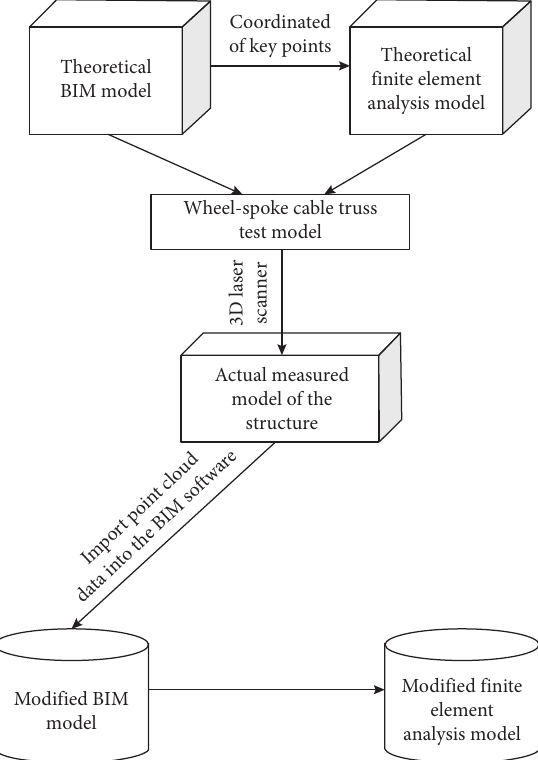
Figure 6: Geometric model building